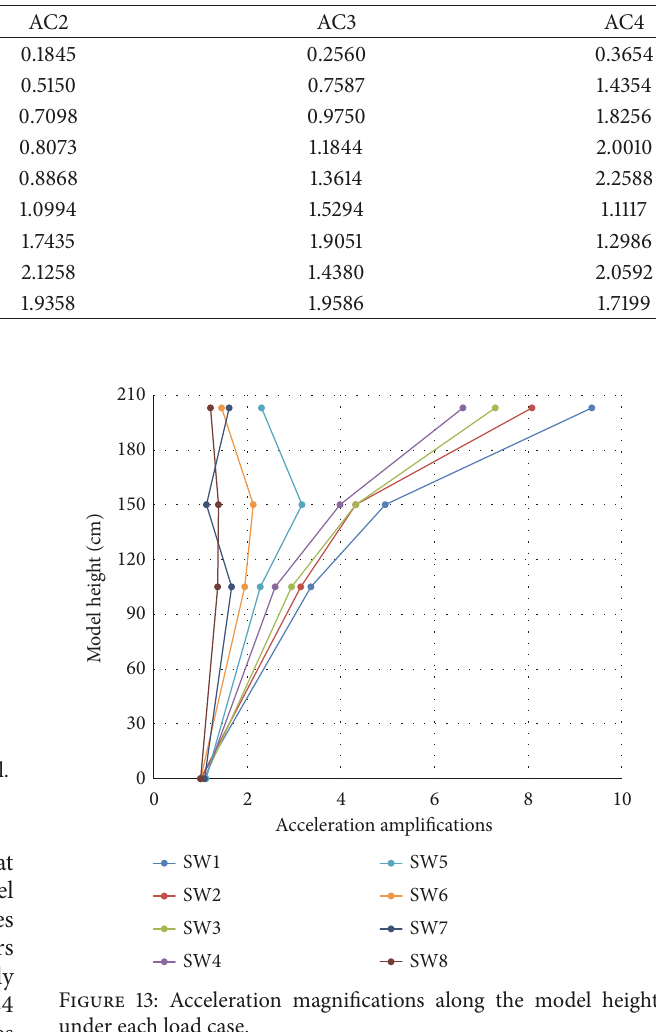
Table 7: Maximum accelerations on the model. AC: Accelerometers; WN: White noise; SW: Seismic wave.